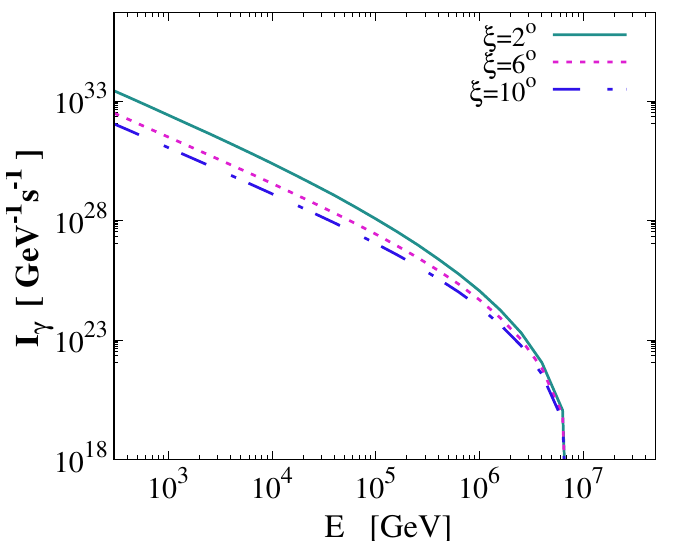
Figure 7. Calculated gamma-ray intensity I γ ( E ) emanating from the LMC X-1 (for z = z 0 ) for three different values of the jet’s half-opening angle ξ (for details see the